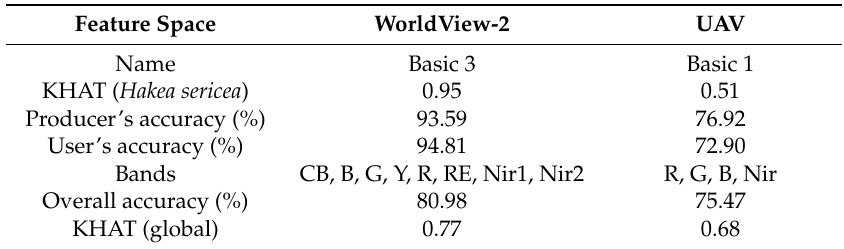
Table 5. Characteristics of the selected feature spaces for classifying the WV2 image and the UAV